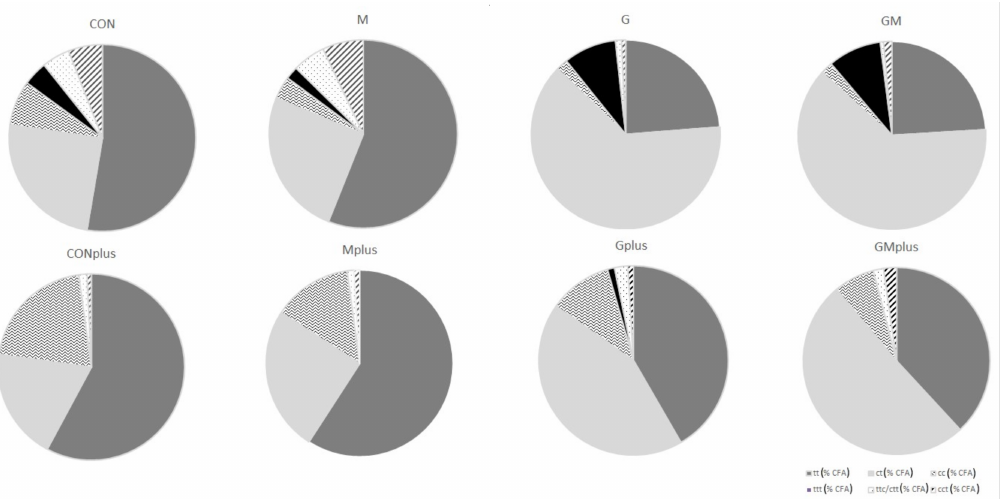
Figure 2. Percentage share of different classes of conjugated fatty acid (CFA) isomers in hepatic microsomes of experimental